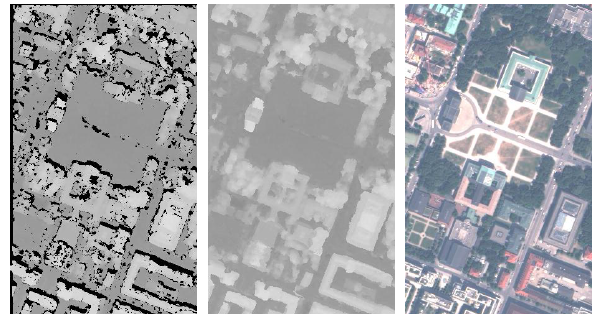
Figure 3: DSM of the same GeoEye scene, 16 × 9 km, 0 to 350 m height